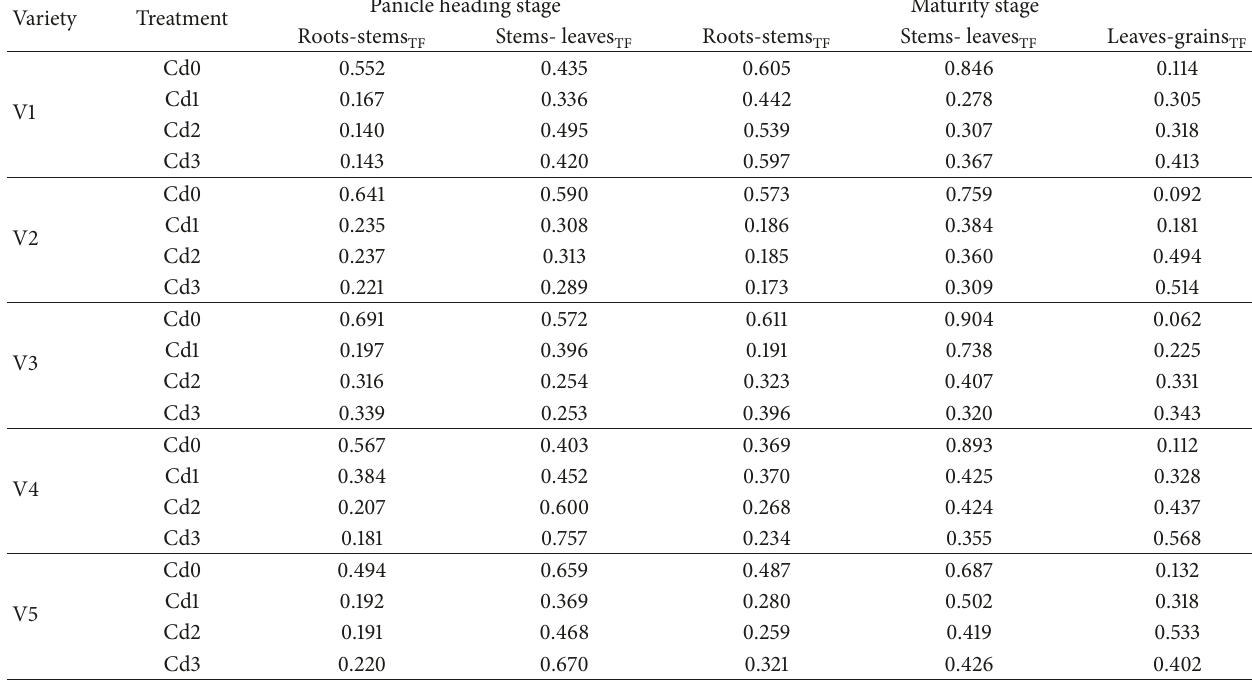
Table 1: Translocation factor (TF) of Cd contents between organs of the five different rice cultivars at panicle heading and maturity stages.